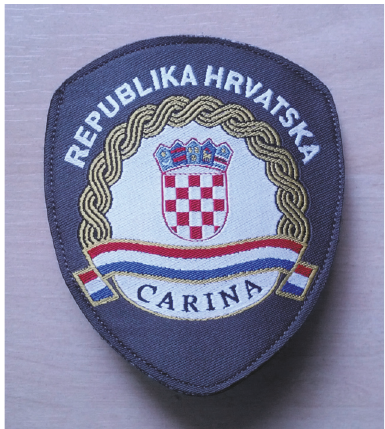
Figure 1: A sleeve badge textile antenna proposed in [20].